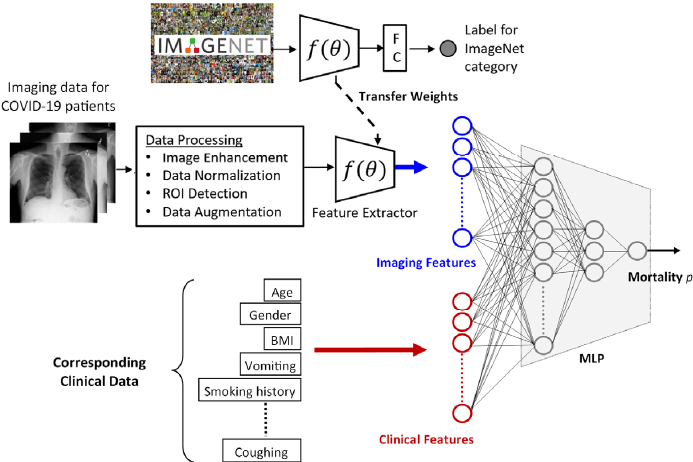
Figure 1. The overview of the mortality prediction framework. The imaging features are acquired using transfer-learned VGG-16 ( f ) and are subsequently processed in tandem with the clinical data features via an MLP to produce the patient’s mortality probability.